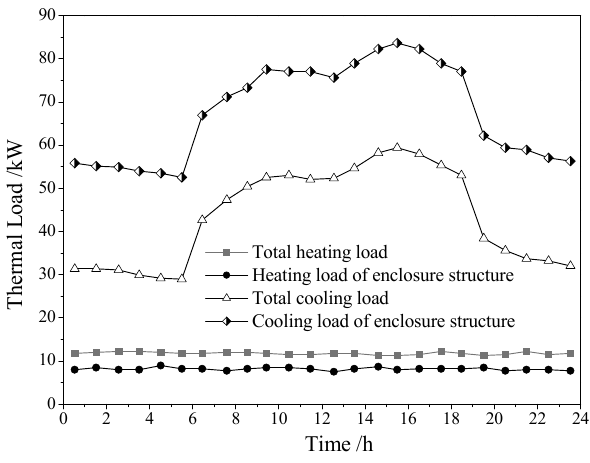
Figure 11. Thermal loads varying with time through a day in summer.